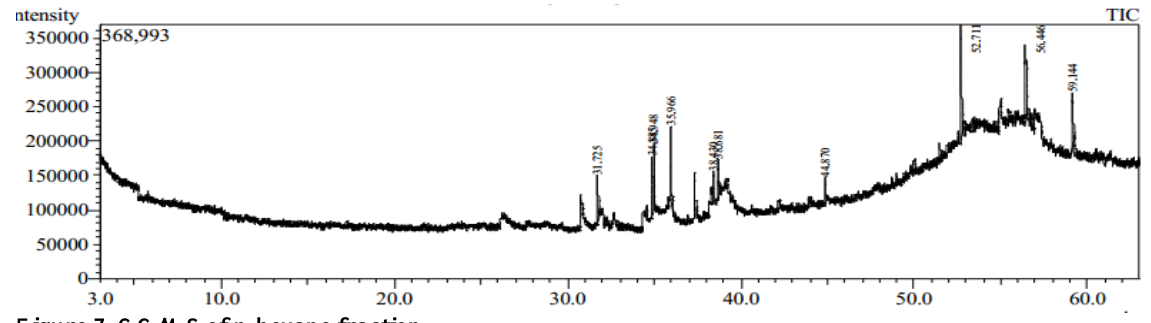
Figure 7. GC/MS of n-hexane fraction . Table 2. Compounds identified in n-hexane fraction by GC/MS. NO. of